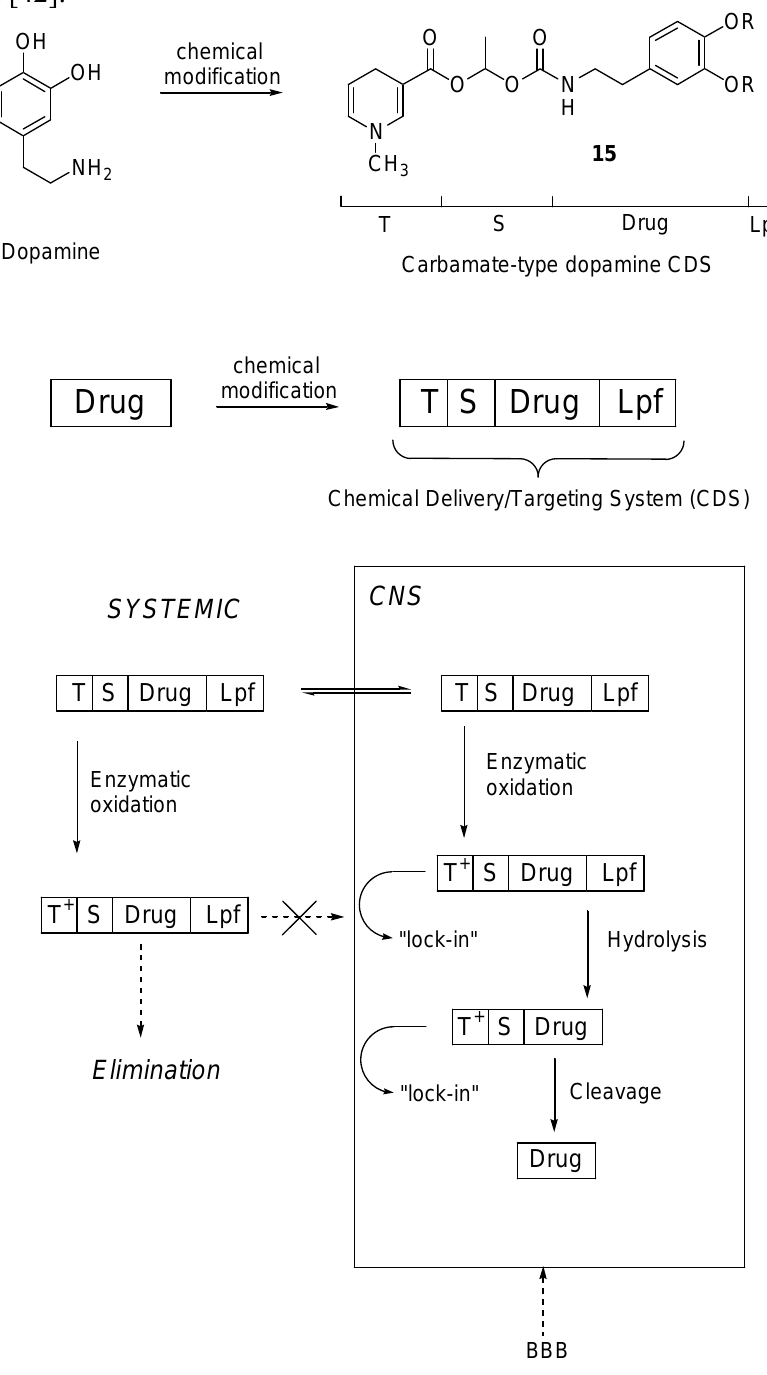
Figure 5. Drug delivery into CNS by molecular packaging and sequential metabolism. The drug is packaged by covalently attached lipophilic groups including a lipoidal Lpf and a 1,4- dihydropyridine “targetor” ( T ) that undergoes enzymatic oxidation and turns to a ionic, membrane-impermeable pyridinium moiety ( T + ). After distribution in the body and into the CNS by crossing the BBB, the CDS is converted to ionic compounds retained in brain tissue, but ionic conjugates produced in the rest of the body are easily eliminated. The membrane- impermeable conjugates “locked” into the brain undergo sequential metabolism and yield the drug in the CNS. A spacer ( S ) function controls the enzymatic rate of drug release. Scheme was drawn on Prokai